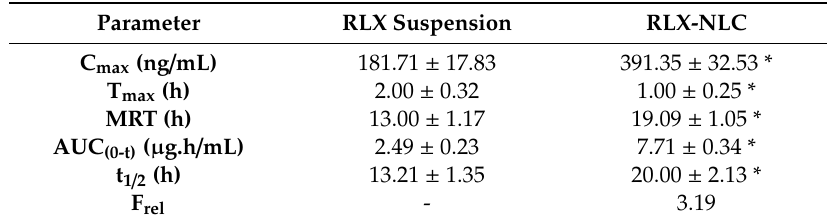
Table 4. Pharmacokinetic parameters of RLX in the oral administration of the optimized NLC formulation (NLC 3) and the RLX suspension in female Wistar rats. * p < 0.05.